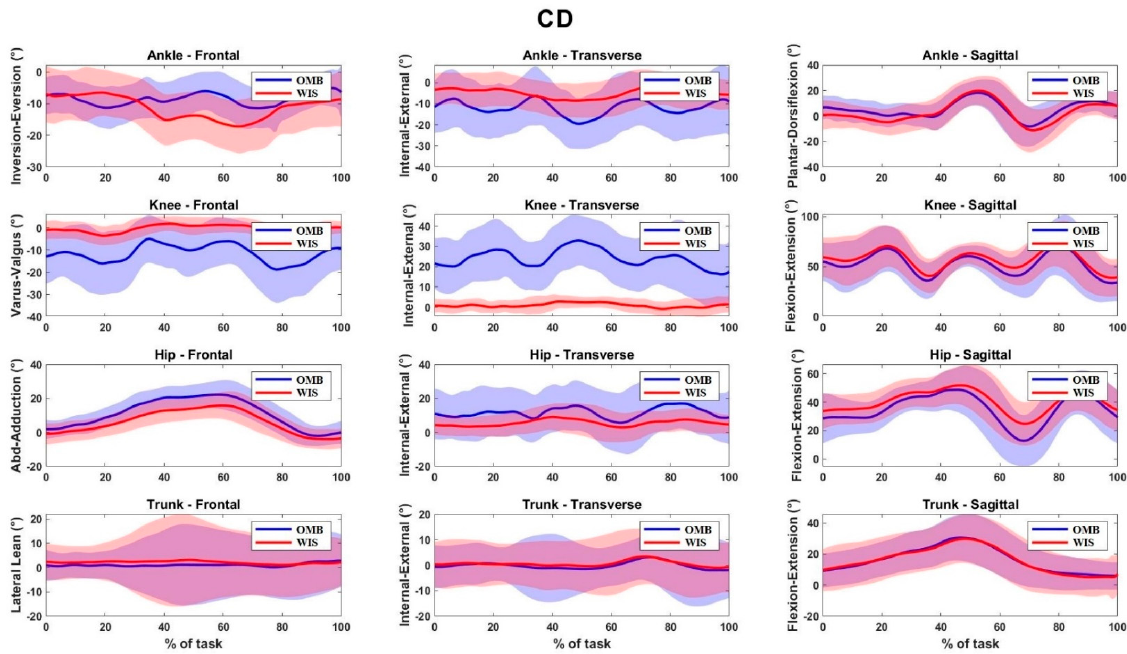
Figure A4. Joint kinematics of marker-based (OMB, blue) and inertial sensors (WIS, red) for the change of direction (CD) task. Data are normalized by the length of the motor task. The waveforms are shown as average (solid lines) and standard deviations (shaded lines).